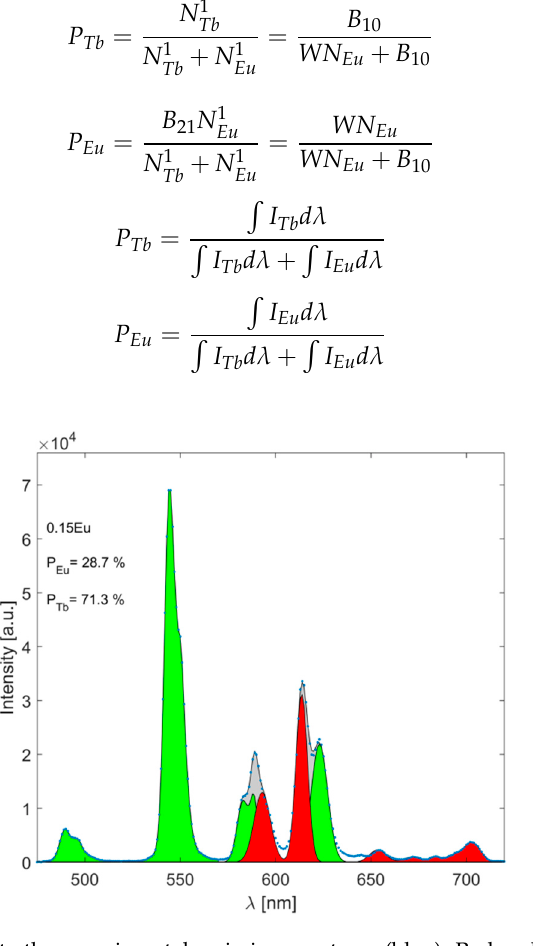
Figure 7. Experimental lifetime curves. The inset is a graph of experimental lifetime. Black lines represent the fitting model. Figure 8 shows the experimental normalized emission spectra according to Equations (11) and 12. Additionally, adjustment of the experimental data was carried out using Equations (9) and (10), with B 10 = 131.2/s. The model simultaneously adjusted the emission spectrum and lifetime curves. Luminescent ef fi ciency can be defined by the ratio of population loss by emission and the population gain of the level: